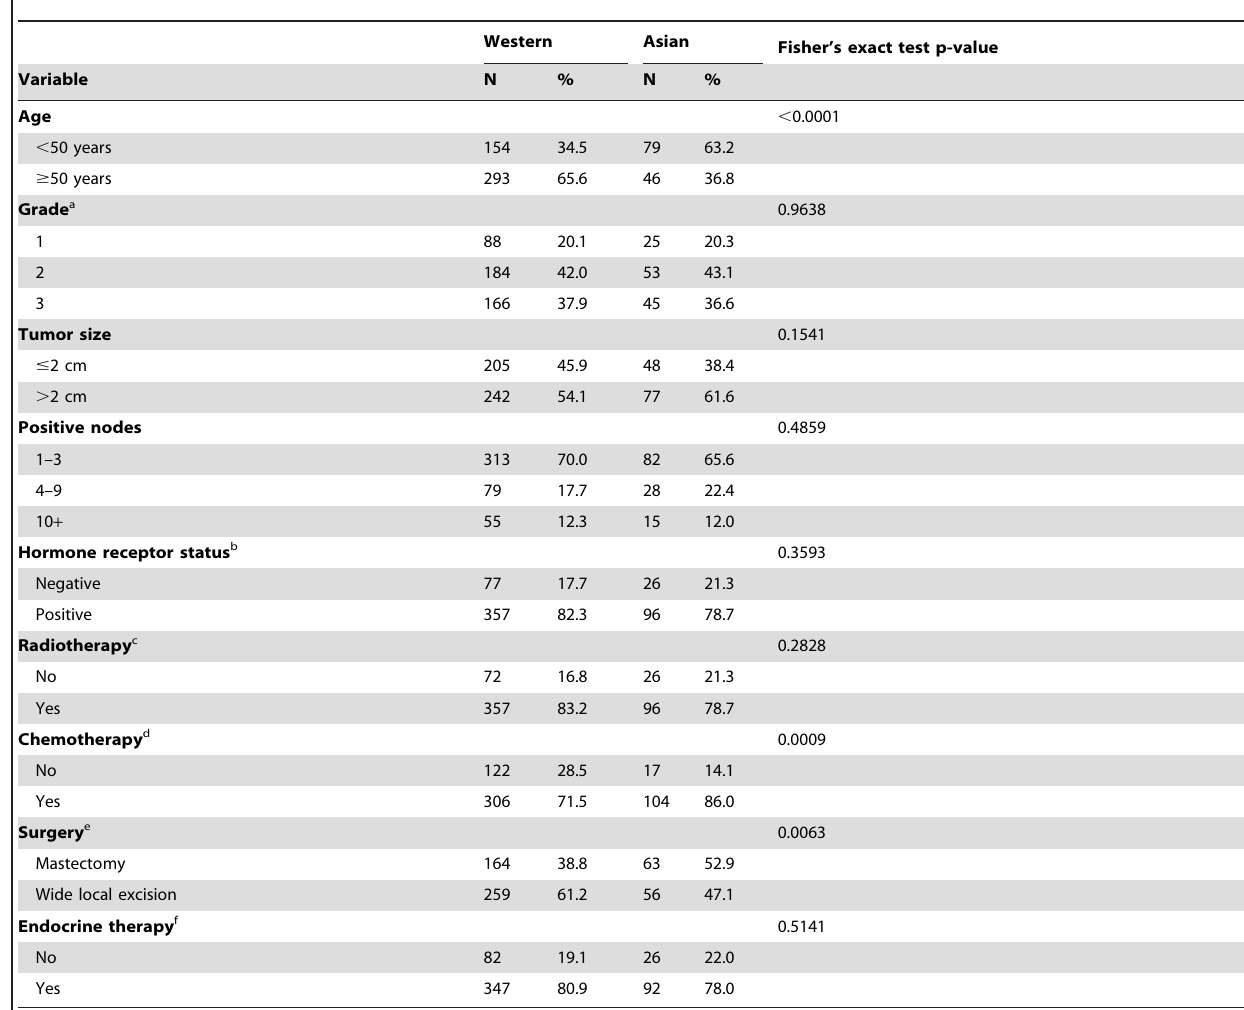
Table 2. Correlation of Asian and Western populations with variables of interest, using Fisher’s exact